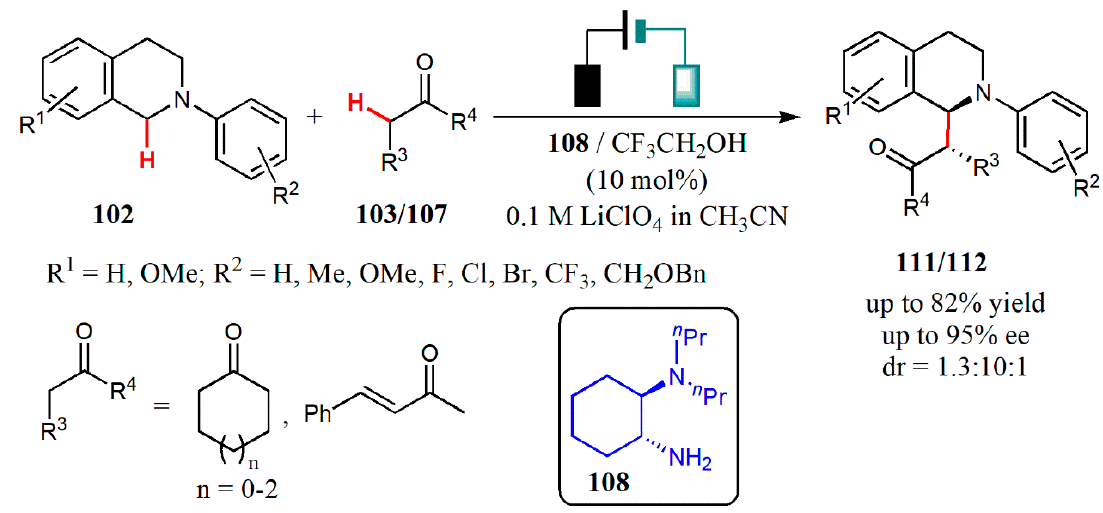
Figure 40. Asymmetric electro-organocatalysis in the α -alkylation of ketones.